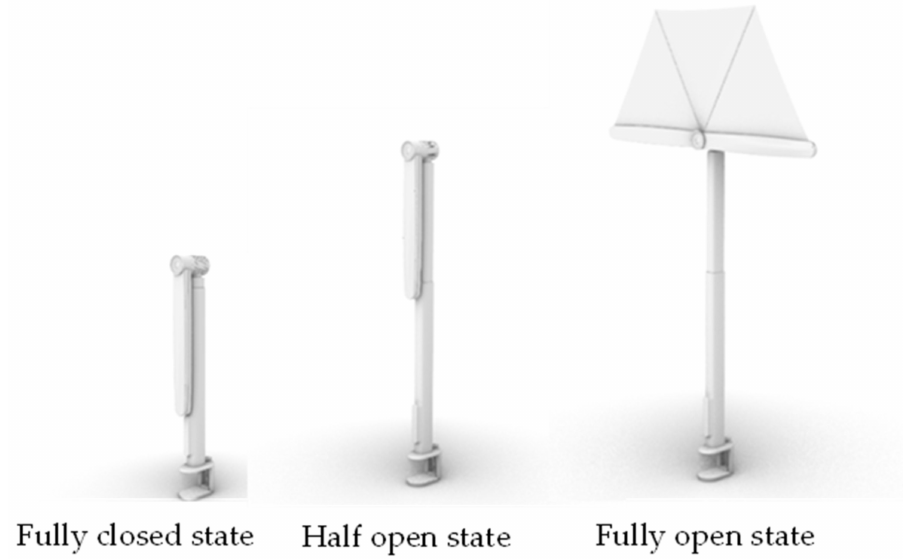
Figure 16. Three states of product.